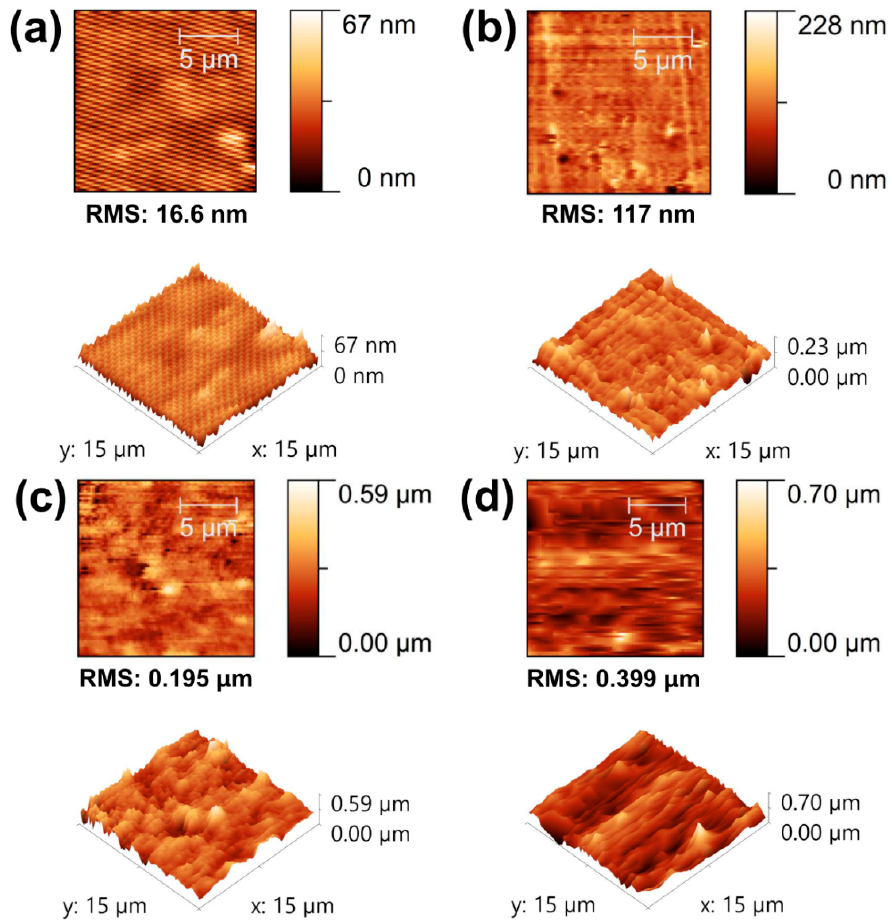
Figure 2. AFM 2D and 3D images ( a – d ) of PDMS, S-PDMS, SG-PDMS-I and SG-PDMS-II of composite films, respectively.